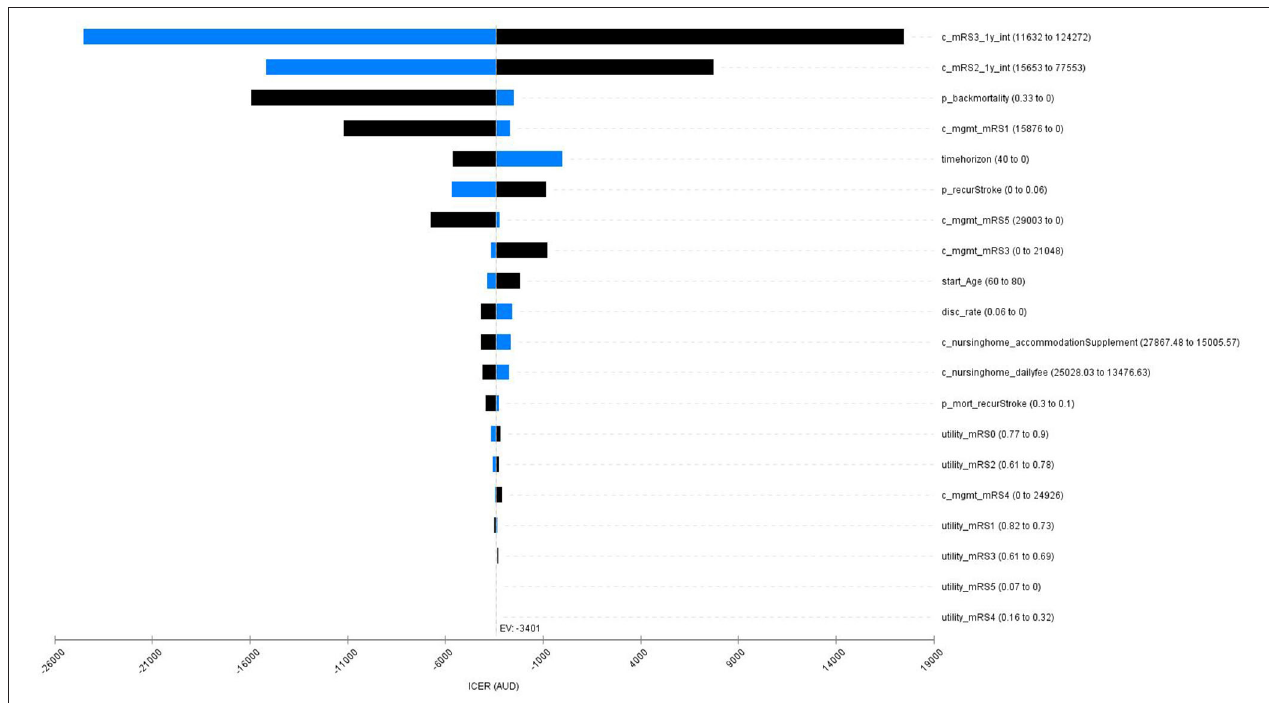
FIGURE 2 | A Tornado diagram for the one-say sensitivity analyses. Red bar means the value increases from the base case; blue bar represents the value decreases from the base case. mRS, modified Rankin Scale; mgmt, management; mort, mortality; c_mRS3_1y_int, cost of management for the intervention group for the first year post stroke (mRS3); c_mRS2_1y_int, cost of mangement for the intervention group for the first year post stroke (mRS2); p_backmortality, probability of background mortality; c_mgmt_mRS1, cost of long-term management post stroke (mRS1); timehorizon, modeled time horizion; p_recurStroke, probability of